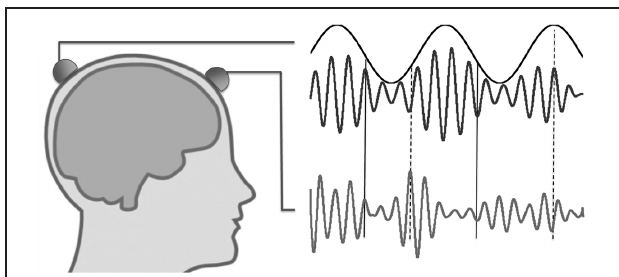
FIGURE 1 | Illustration of nested oscillations and nested synchrony. In nested oscillations, the phase of the slower oscillation modulates the higher-frequency amplitude measured at the same scalp location (two upper traces), but not that measured at a different location (lower trace). In contrast, nested synchrony means that the two faster oscillations become more tightly coupled in certain phases of the slow oscillation (around solid vertical lines) than in other phases (around dashed vertical